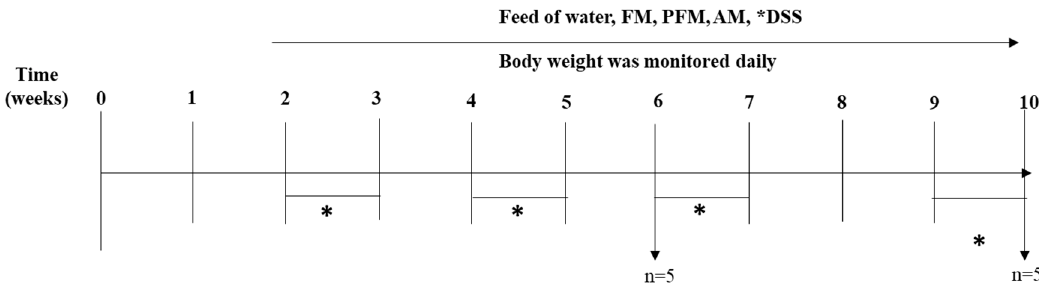
Figure 1. Experimental design. FM + DSS, PFM + DSS, and AM experimental groups of mice received daily treatments from Week 1 to Week 10. Mice received DSS in Week 2, 4, 6, and 9. *DSS administration period